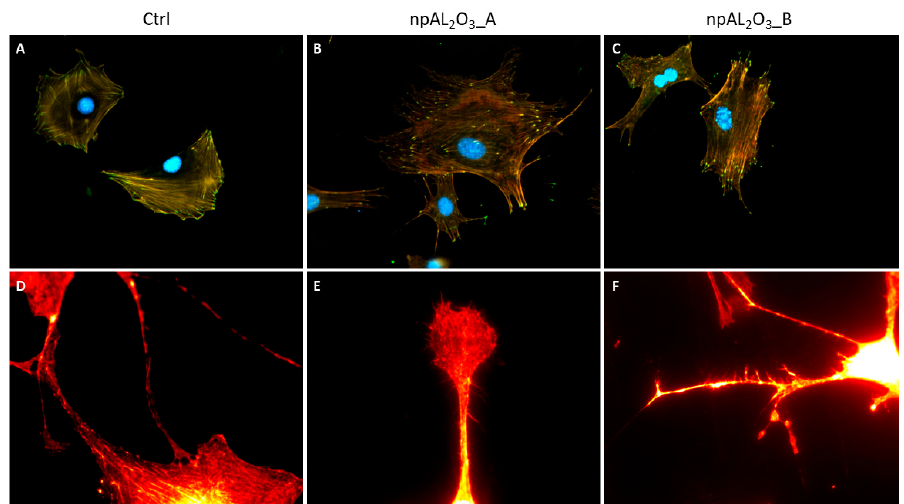
Figure 5. Representative pictures of MC3T3-E1 morphology. Fluorescence photomicrographs of MC3T3-E1 seeded on the control condition ( A , D ), npAl 2 O 3 _A ( B , E ), and npAl 2 O 3 _B ( C , F ). The cells were stained for the nucleus (DAPI, blue), the actin (rhodamine-phalloidin, red), and the focal adhesions (paxillin, green) at 200 magnifications ( A – C ) or only for actin at 900 magnifications ( D – F ).